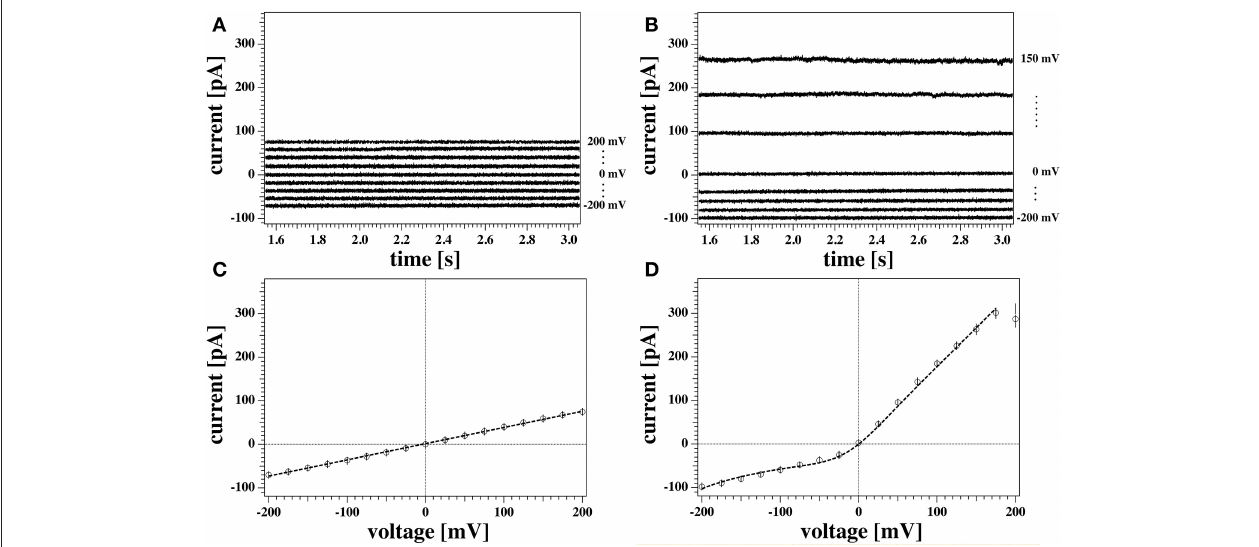
FIGURE 5 | (A,B) Detail of the last 1.5 s of two representative current responses to the voltage pulses shown in Figure 3 recorded from the same membrane. The graph shows the response to only every other voltage step for clarity. Current traces were corrected for the initial offset at zero voltage. Currents in (A) were measured with the tip of the pipette at the air/water interface. Traces in (B) were measured with the tip of the pipette 3 mm below the water surface. (C,D) Current-voltage relationship for the traces in (A,B) , respectively. All points of all the current traces between 1.5 and 3 s were plotted and fitted. The model used for the fit were a linear relation in (C) , and Equation (5) in (D) as outlined in the Theory section. The fit gives a conductance of g L = 372 ± 4 pS for the recording in (A,C) , and a voltage offset of V 0 = 209 mV for the recording in (B,D) . Solid circles show the average values of the current. The measurements were performed at a temperature of T = 297.85